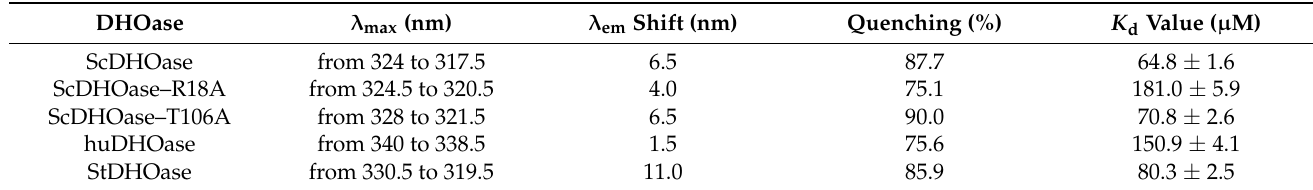
Table 3. Binding parameters of